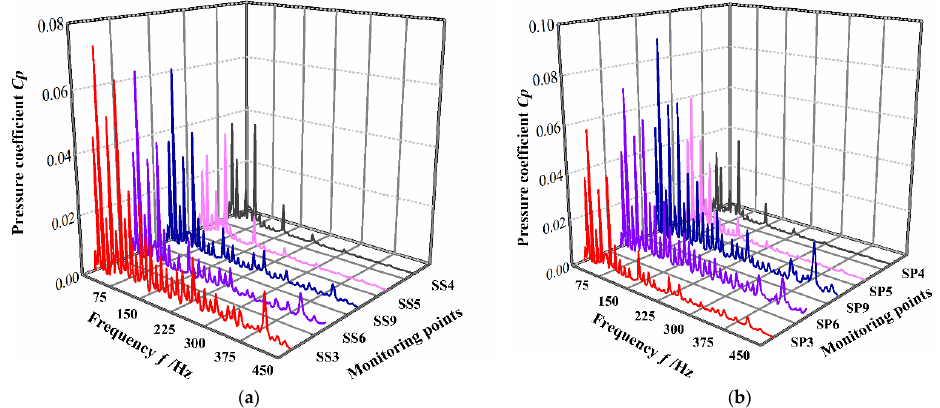
Figure 9. Frequency domain diagram of single-suction impeller at design flow rate condition. ( a ) Blade Suction Side, ( b ) Blade Pressure Side.